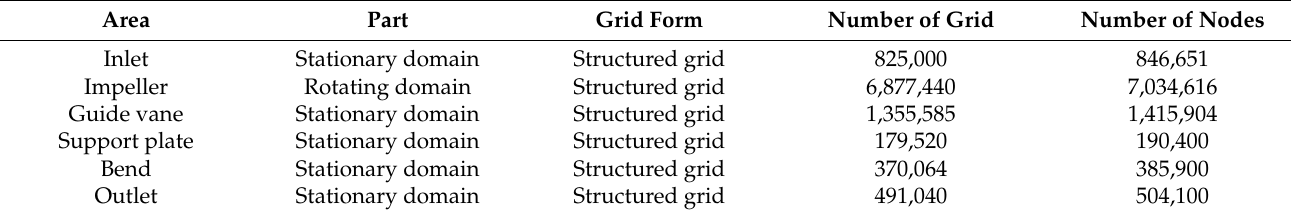
Figure 3. Grid of main water body calculation domain. Table 2. Local grid